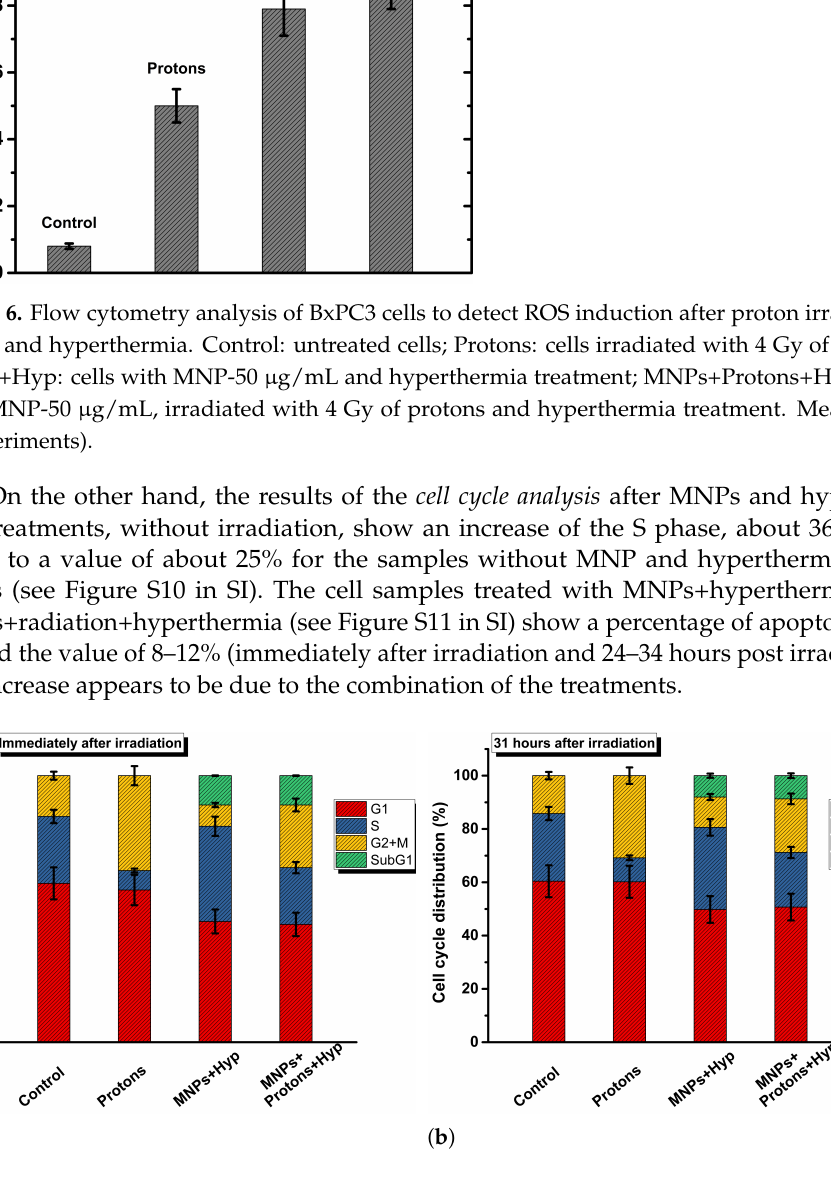
Figure 7. Cell cycle phase distribution of BxPC3 cells after proton irradiation, MNPs and hyperther- mia. Control: untreated cells; Protons: irradiated cells; MNPs+Hyp: cells with MNP-50 µ g/mL and hyperthermia treatment; MNPs+Protons+Hyp: cells with MNP-50 µ g/mL, irradiation and hyperther- mia treatment. Cell cycle phases are evaluated immediately after ( a ) and 31 h after ( b ) the irradiation. Cell invasion is related to cell migration and defines the ability of cells to become